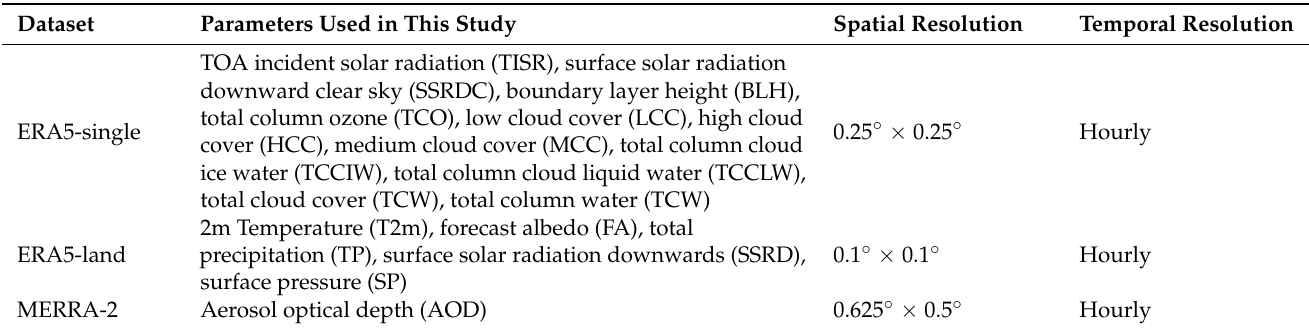
Table 1. Basic information of input variables from three reanalysis data: MERRA_2, ERA5-single, and ERA5-land.